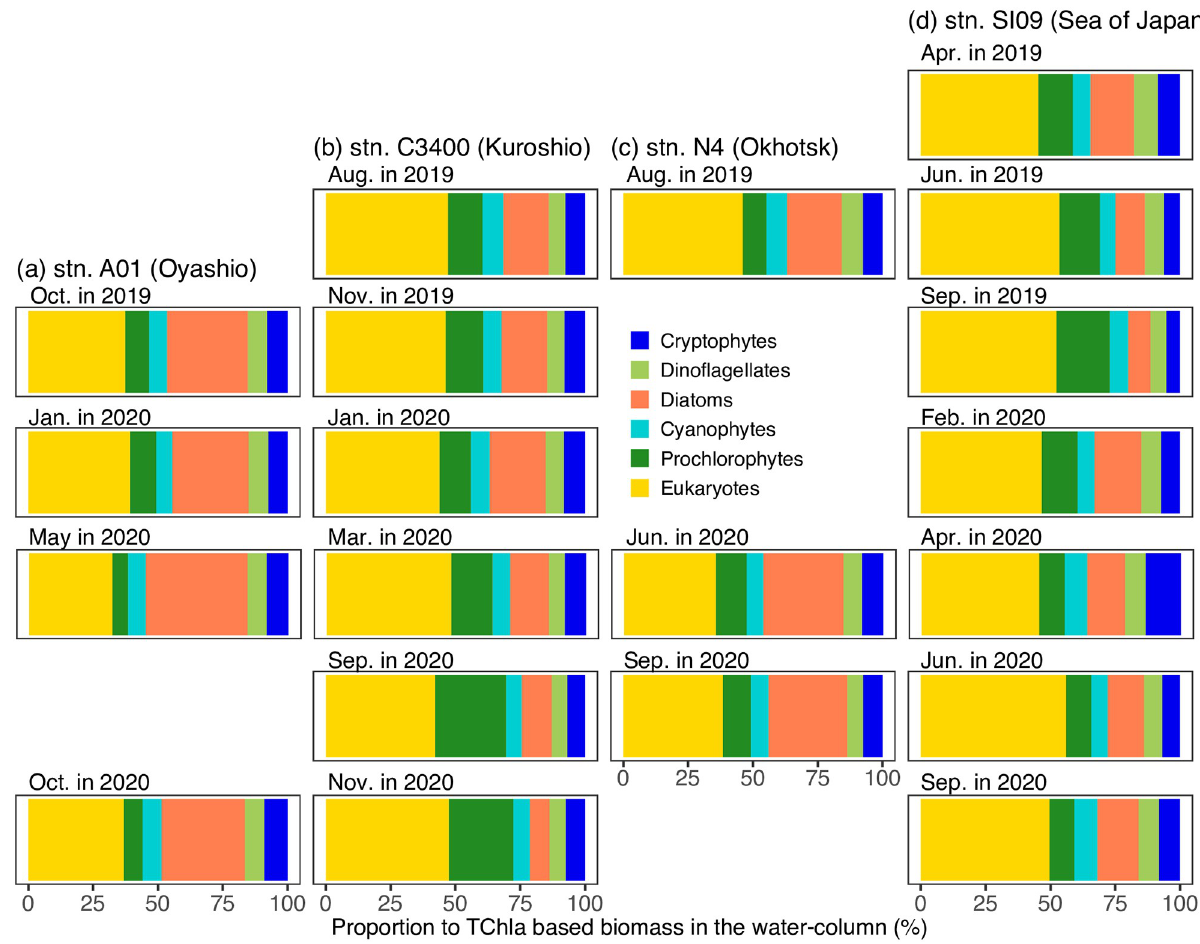
Fig 9. Temporal and spatial variations of proportion to Tchla-based biomass in the water column. The water-column integrated Tchla-biomass was calculated (a) from 2 to 100 m depth at stn. A01 in the Oyashio, (b) from 2 to 200 m depth at stn. C3400 in the Kuroshio, (c) from 2 to 100 m depth at stn. N4 in the Okhotsk Sea, and (d) at from 2 to 150 m depth stn. SI09 in the Sea of Japan (JS).